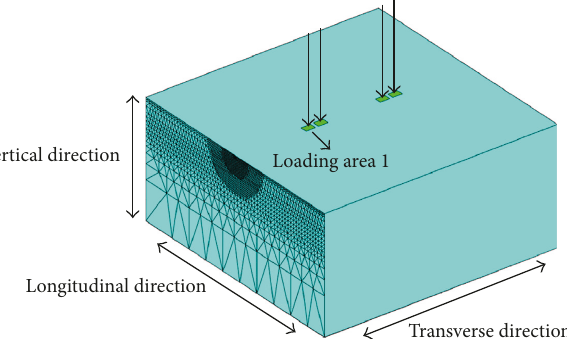
Figure 11: Mesh automatically generated from SAFEM.